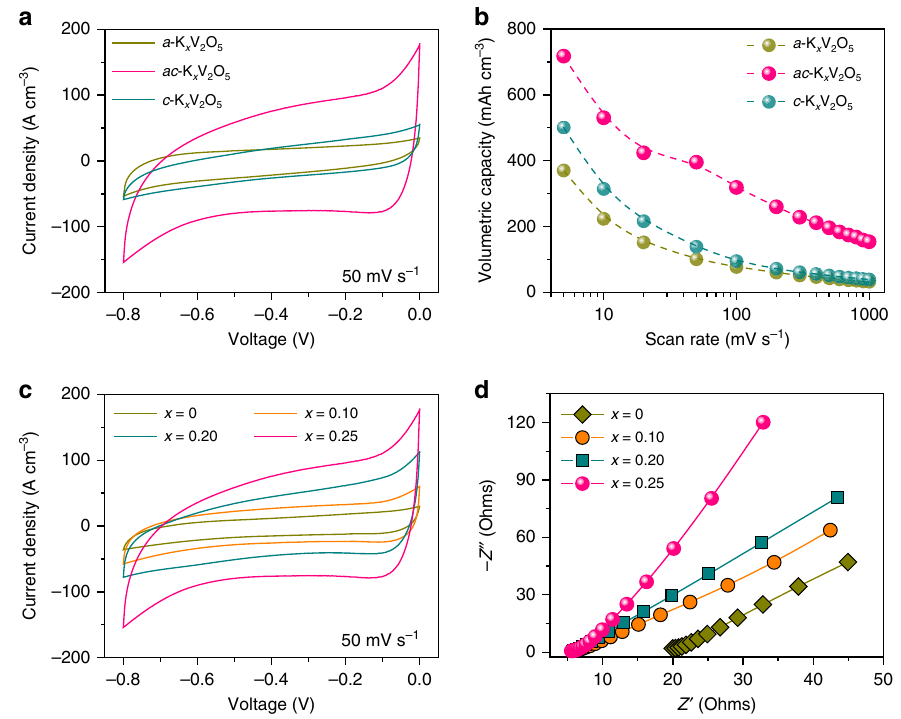
Fig. 3 Electrochemical characterization of anodic nanoporous Au/K x V 2 O 5 microelectrodes. a Representative CV curves of nanoporous Au supported a - K x V 2 O 5 , ac -K x V 2 O 5 , and c -K x V 2 O 5 ( x = 0.25) microelectrodes that are annealed at 25, 200, and 300 °C, respectively. Scan rate: 50 mV s − 1 ; electrolyte: 0.5 M K 2 SO 4 . b Volumetric capacities of nanoporous Au/K x V 2 O 5 ( x = 0.25) microelectrodes with the constituent a -K x V 2 O 5 , ac -K x V 2 O 5 , and c -K x V 2 O 5 (annealed at 25, 200, and 300 °C) at various scan rates from 5 to 1000 mV s − 1 . c Representative CV curves of nanoporous Au/ ac -K x V 2 O 5 ( x = 0, 0.1, 0.2, and 0.25) microelectrodes that are annealed at 200 °C. scan rate: 50 mV s − 1 ; electrolyte: 0.5 M K 2 SO 4 . d EIS spectra of nanoporous Au/ ac -K x V 2 O 5 ( x = 0, 0.1, 0.2, and 0.25) microelectrodes annealed at 200 series resistances ( R I = 5.53 Ω and R CT = 0.28 Ω ) (Supplementary Fig. 10c) and the highest Z w value (3358 S s 1/2 ) (Supplementary Fig. 10d), re fl ecting the superior ion accessibility/diffusion and charge transfer in the dual-phase nanostructure during the elec- trochemical energy storage. The distinguished electrochemical behavior of the NP Au/ ac -K x V 2 O 5 microelectrode is further elucidated by charge/discharge kinetics analysis with an assumption that the current density ( i ) obeys a power-law rela- tionship with the scan rate ( v ) 52,53 , namely i = av b , where a is an adjustable parameter, the b value of 0.5 or 1 represents a diffu- sion- or surface-controlled process, respectively. In the ln( i ) − ln ( v ) plots (Supplementary Fig. 8e), the b value of the NP Au/ ac - K x V 2 O 5 is determined to be 0.86 due to enhanced insertion/ extraction kinetics of the hydrated K + cations, in contrast with those of the NP Au/ a -K x V 2 O 5 (0.60) and NP Au/ c -K x V 2 O 5 (0.64) with evident limitations of poor accessibility and slow diffusion. Figure 3c and Supplementary Fig. 11a – d compare the CV curves of NP Au/ ac -K x V 2 O 5 microelectrodes, of which the constituent ac -K x V 2 O 5 has K + components changed from 0 to 0.25, at various scan rates. Owing to the maintenance of amorphous nanodomains of K 0.25 V 2 O 5 · n H 2 O in the constituent ac -K x V 2 O 5 , the NP Au/ ac -K x V 2 O 5 microelectrodes exhibit evidently improved current densities compared with the one with the constituent K + -free ac -V 2 O 5 , i.e., NP Au/ ac -V 2 O 5 . Furthermore, the current density of NP Au/ ac -K x V 2 O 5 micro- electrode increases with the increasing x value, which enlists the NP Au/ ac -K x V 2 O 5 with x = 0.25 to achieve a volumetric capacity of as high as ~715 mAh cm − 3 at 5 mV s − 1 (Fig. 3b), about threefold the value of NP Au/ ac -V 2 O 5 (~242 mAh cm − 3 ) (Supplementary Fig. 11e, f). Even when increasing the scan rate